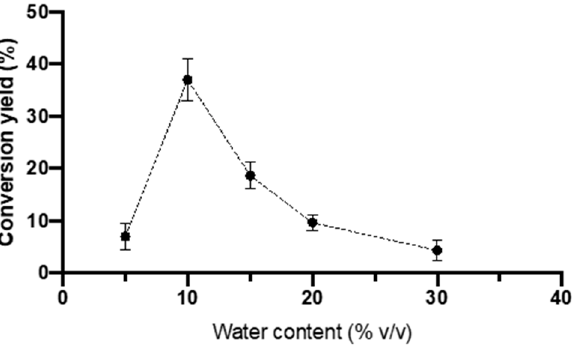
Figure 2. Effect of the amount of water on the ester yield for PPL. Reaction time: 15 h (equilibrium condition). All measurements were performed in triplicate.